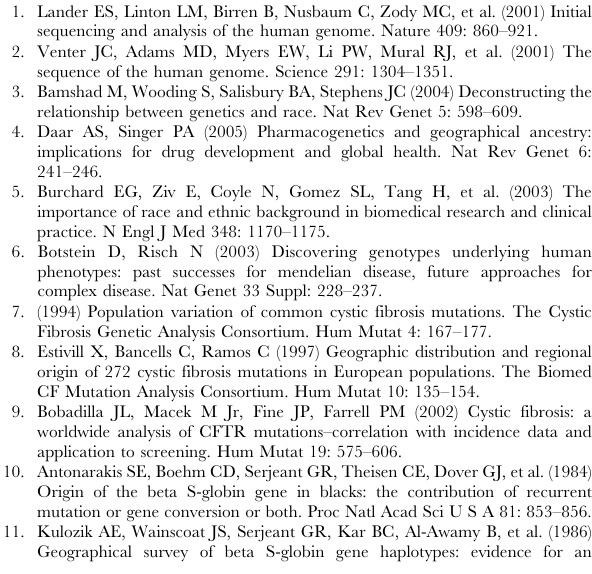
each gene (see Khaitovich et. al, 2005). dn/ds: number of non- synonymous substitutions per non-synonymous site divided by the number synonymous substitutions per silent site. Table S8 Linkage disequilibrium for SNPs and CNVs. In the table it is reflected the calculated r-squared value (r2) and the SNP showing the maximum LD with the copy number state revealed by the MLPA probes in the first column. Values were obtained for each population independently and considering all populations together. The column SNPs indicates the number of HapMap SNPs retrieved for each analysed region flanking the CNV. For three of the probes it was not possible to measure LD because more than three copy number states were present (**) or because no SNP data was available for individuals showing the CNV (***). Table S9 Haplotype structure correlation between populations. LD patterns correlation between populations was measured using the Spearman’s rank correlation test. High Rho values indicate correlation and p-values below 0,05 denote significance for the correlation. For three of the probes it was not possible to measure LD because more than three copy number states were present (**) or because no SNP data was available for individuals showing the CNV (***).